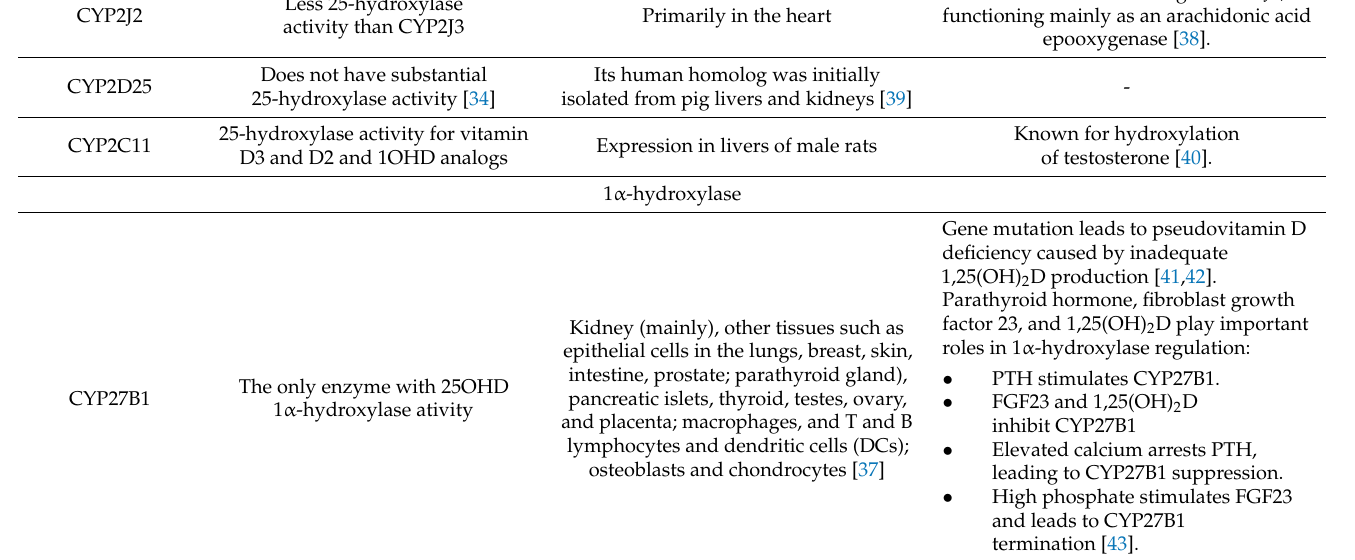
mutations cause cerebrotendinous xanthomatosis, abnormal bile and cholesterol metabolism, but not rickets